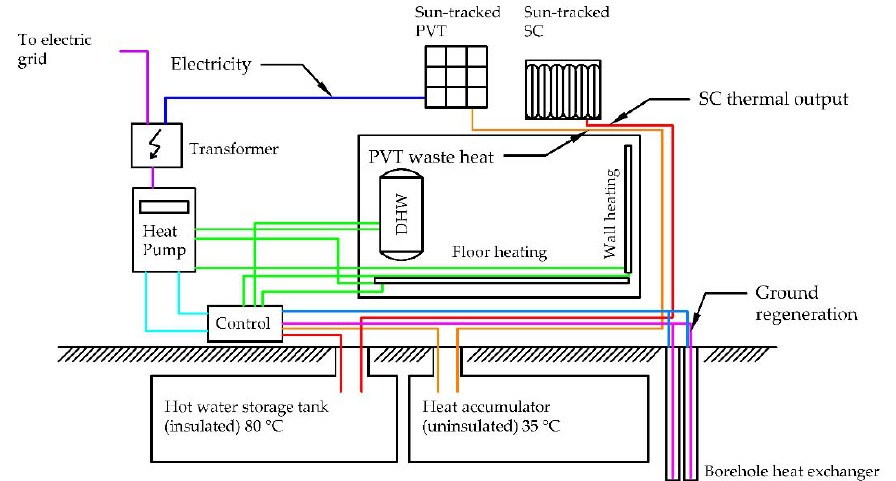
Figure 4. Schematics of RESHeat system. Reprinted with permission from ref. [23]. 2021 Oc ł o ń .